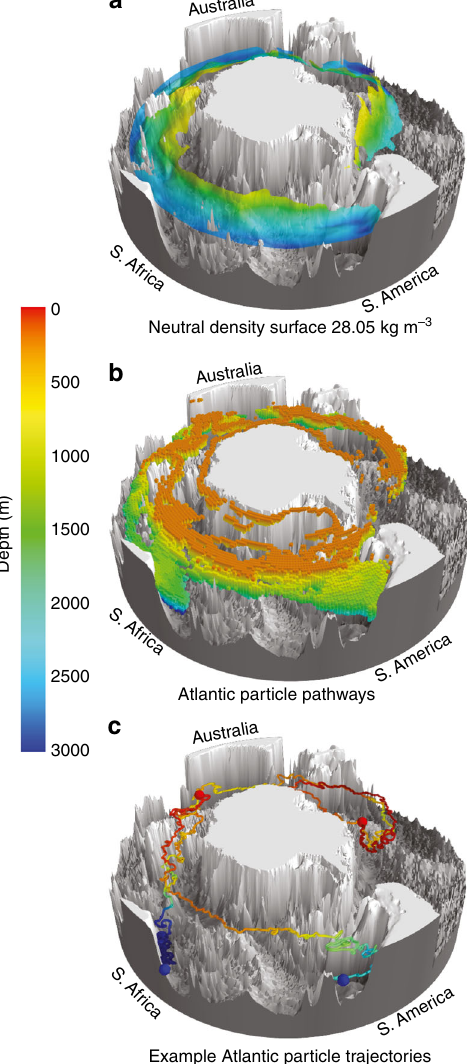
Fig. 1 The three dimensional upward spiral of North Atlantic Deep Water through the Southern Ocean. a Observed warm water ( > 1.6 °C) on the 28.05 kg m − 3 neutral density surface from hydrographic observations 27 , south of 40° S, colored by depth (m). The isoneutral surface is masked in regions with potential temperature below 1.6 °C. 1/4° ocean bathymetry 70 is shown in gray . b Modeled (CM2.6) particle pathways from the Atlantic Ocean, with particles released in the depth range 1000 – 3500 m along 30° S. Colored boxes mark 1° latitude × 1° longitude × 100 m depth grid boxes visited by > 3.5% of the total upwelling particle-transport from release at 30° S to the mixed layer. Boxes are colored by depth, similar to a . c Two example upwelling particle trajectories from CM2.6, one originating from the western Atlantic and the other from the eastern Atlantic. Trajectories are colored by depth as in a and b , blue spheres show the particle release locations and red spheres show the location where the particles reach the mixed layer. Three-dimensional maps were produced using Python and Mayavi